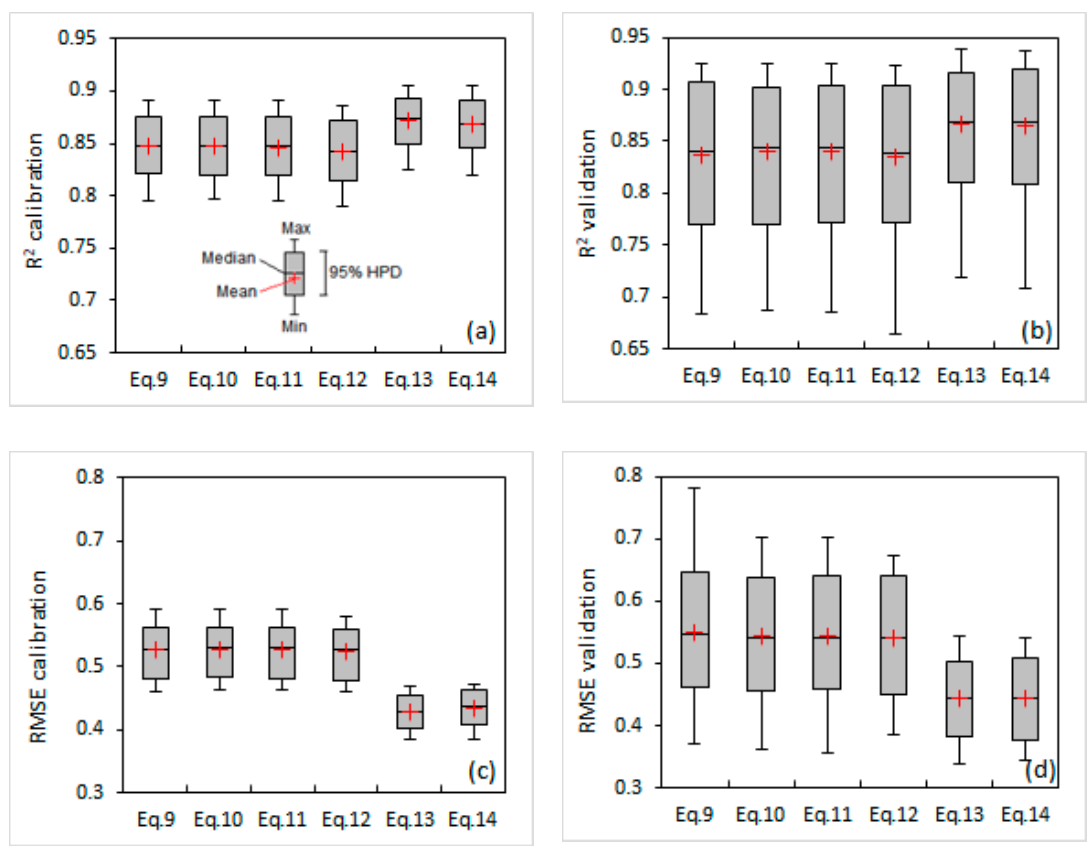
Figure 2. Range of ( a,b ) R 2 and ( c,d ) root mean square error (RMSE) during calibration and validation of the six models (Equations (9)–(14)) presented as modified box-whisker plots, with boxes adjusted to the 95% HPD interval.